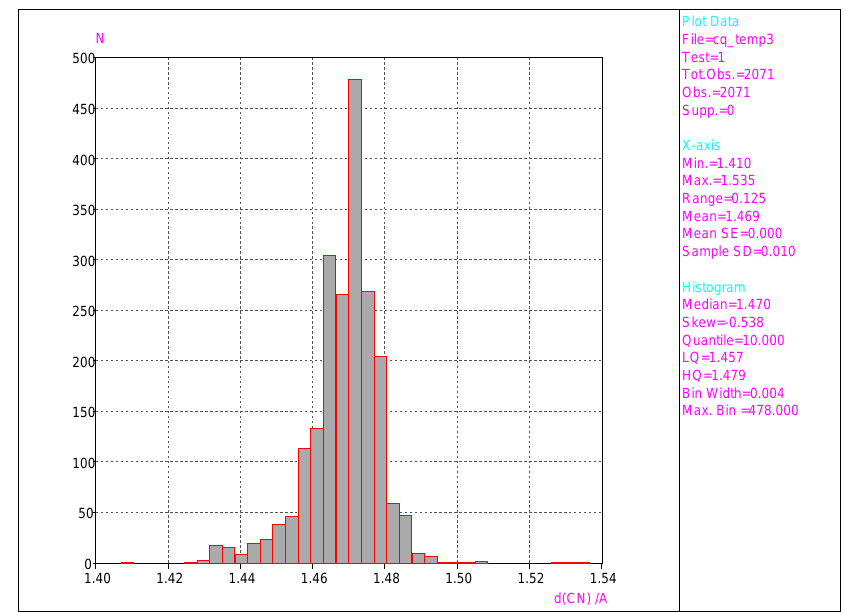
Figure 5. Distribution of CN bond length for para -substituted nitrobenzene derivatives.